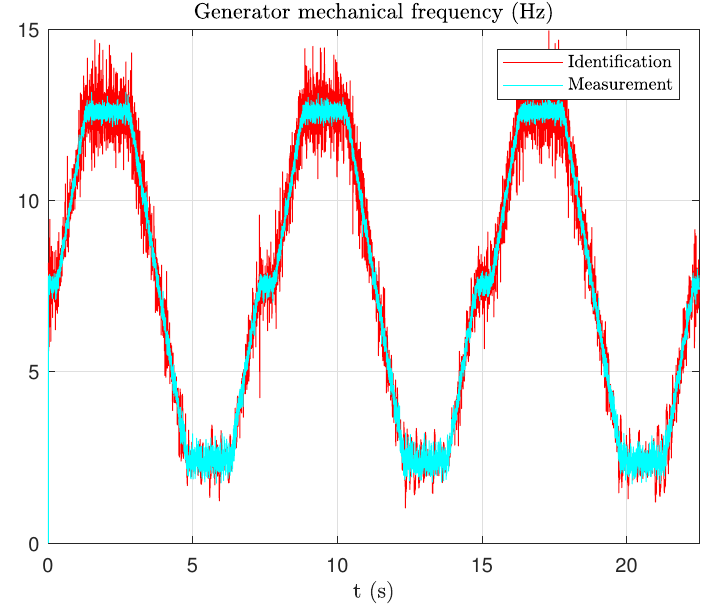
Figure 8. Generator mechanical frequencies, m 2 = 7200, m 3 = 6.7 × 10 − 3 .